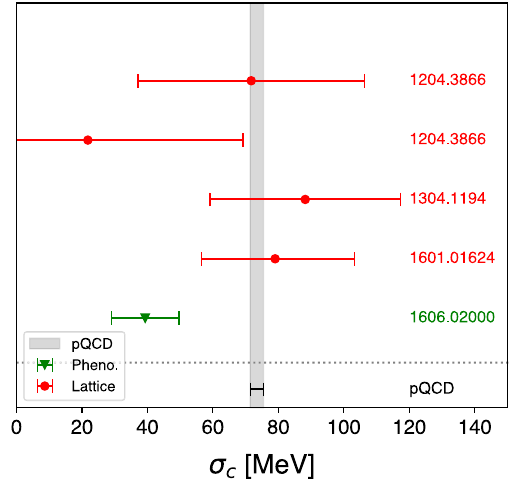
Fig. 8 Calculations of σ c (in MeV units). Those made using the lattice are indicated in red, and one relying on phenomenological inputs is indicated in green. We also show the O (α 3 s ) perturbative calculation (33) (bottom line and vertical grey band)